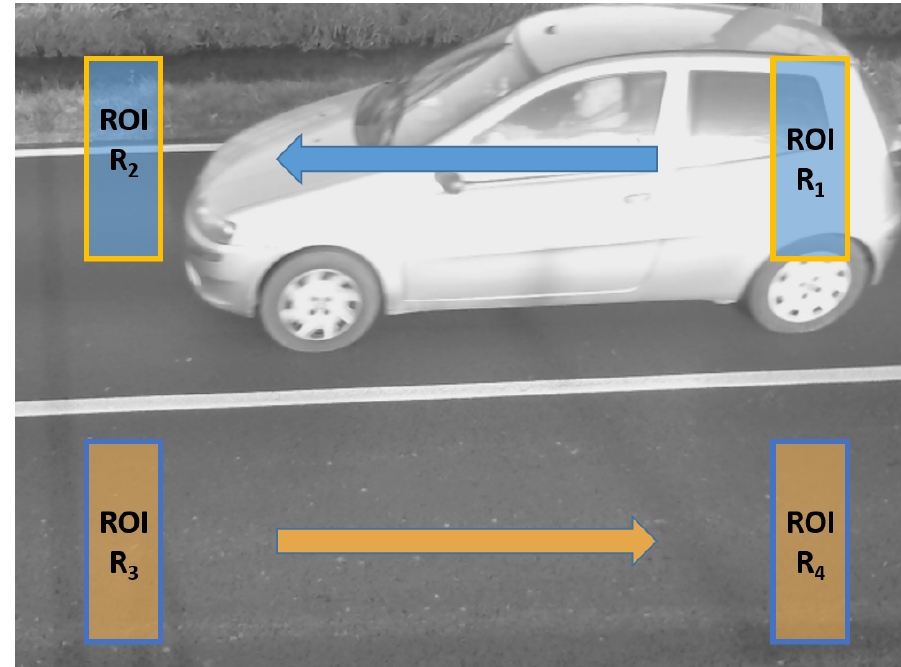
Figure 7. Traffic flow analysis: view from sensor test set-up and example of vehicles transit in the field of view of the sensor, which may cause occlusion to the upper lane.